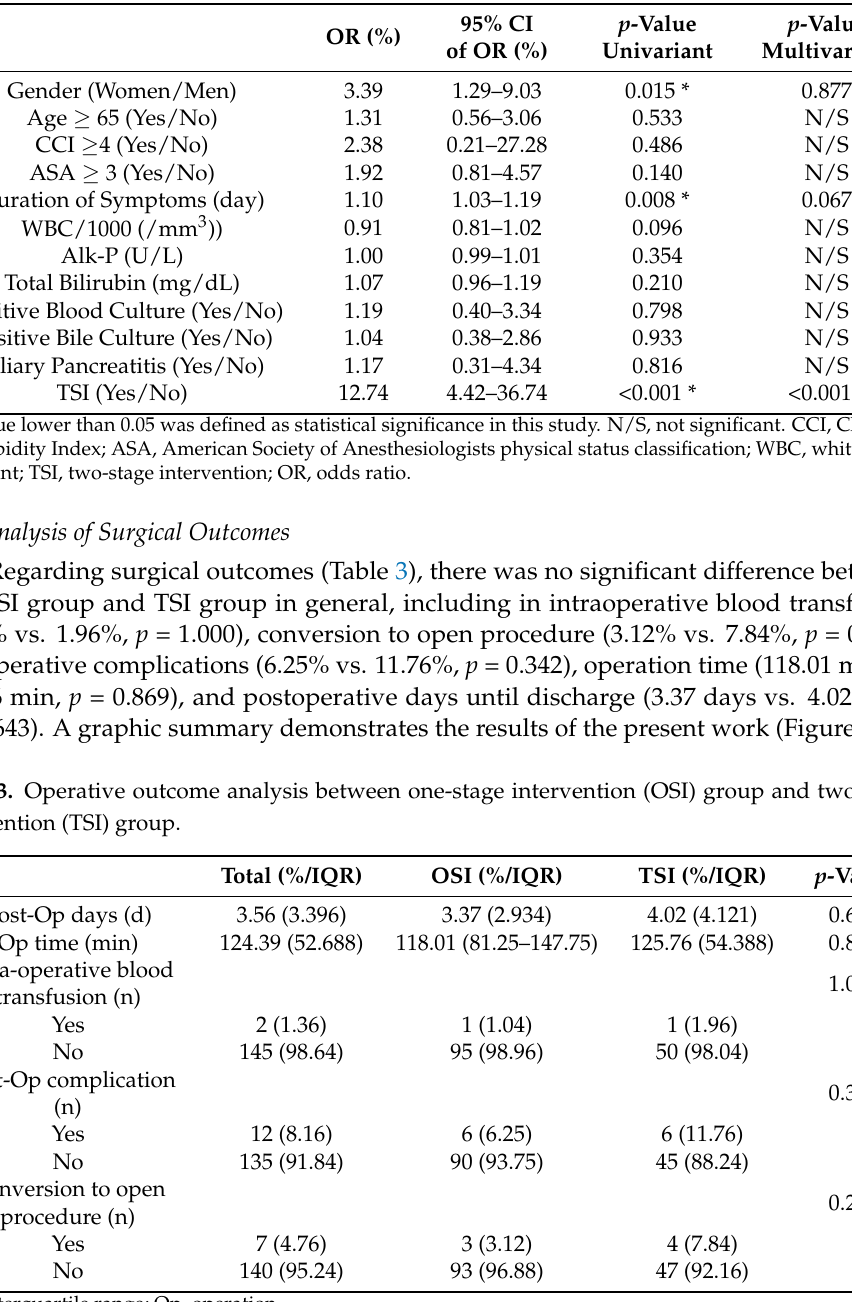
Table 2. Univariant and multivariant analysis of risk factors for overall recurrent biliary event (RBE).